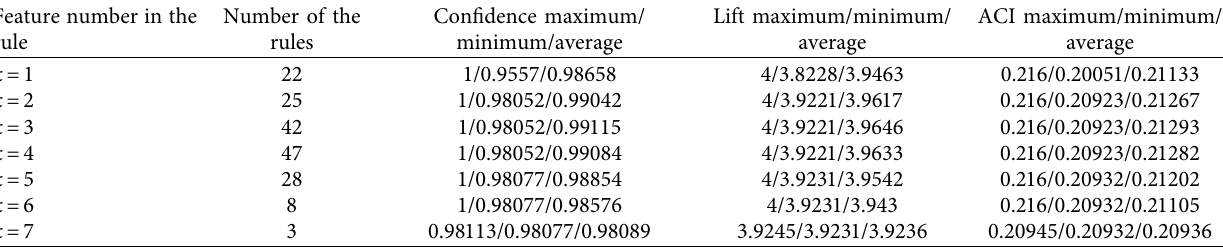
Table 3: Result of fault diagnosis rule extraction.